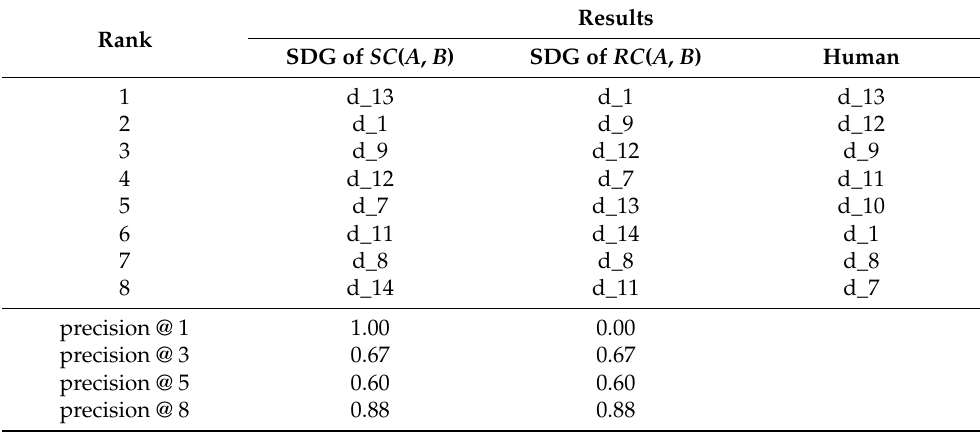
Table 6. Ranking results of Models SC ( A , B ) and RC ( A , B ) as well as human evaluation for high cognitive diversity case: CD ( A , B ) = 1.67.